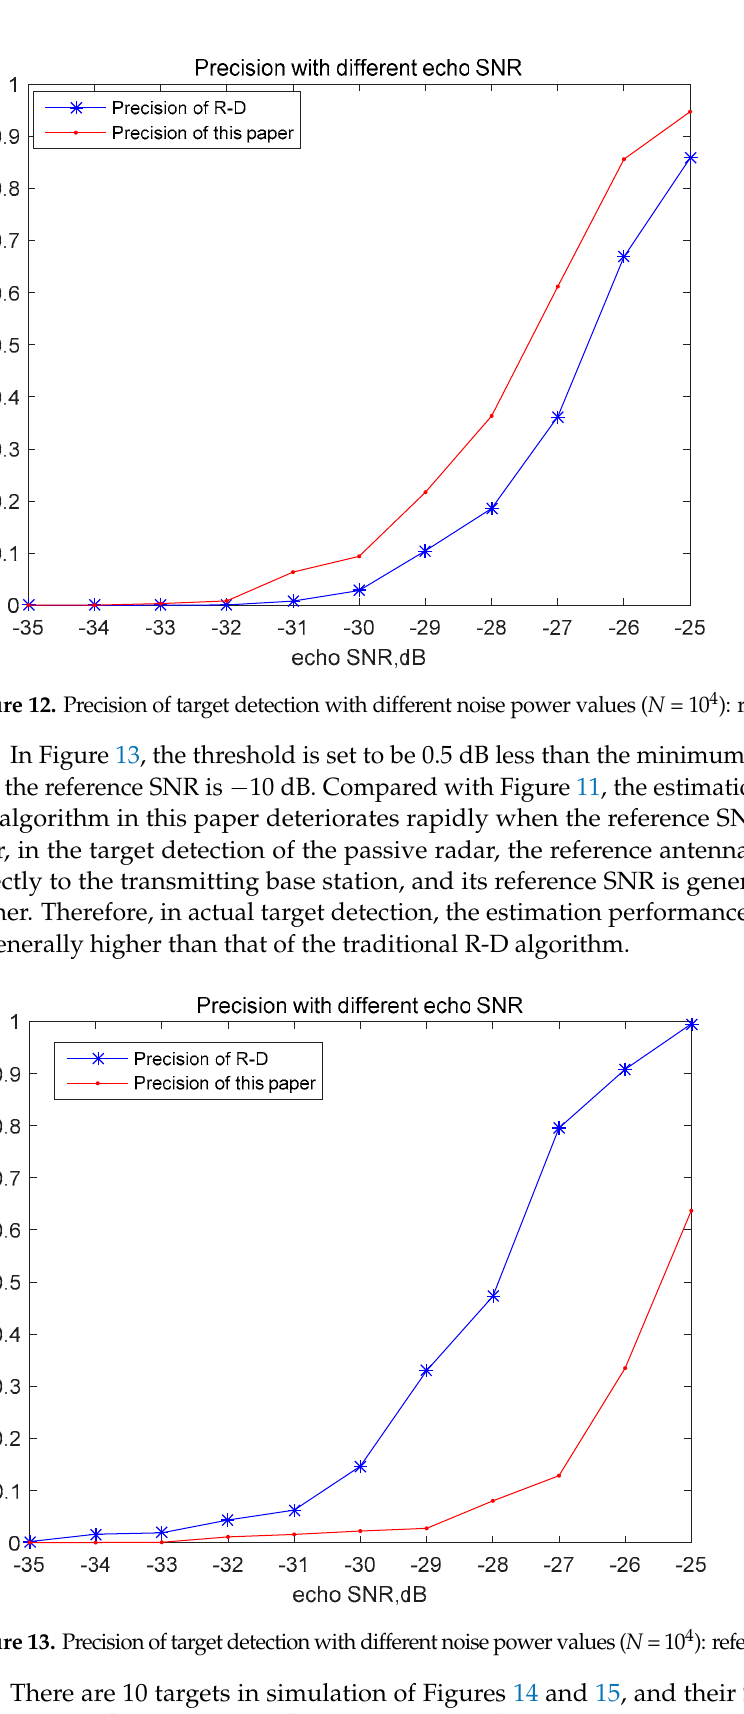
Figure 13. Precision of target detection with different noise power values ( N = 10 4 ): reference SNR = − 10 dB. There are 10 targets in simulation of Figures 14 and 15, and their SNR is uniformly distributed in [ − 40 dB, − 20 dB]. Each point in the figure has been subjected to 10,000 Monte Carlo simulations. The SNR reference channel is 10 dB in Figure 14 and it is − 5 dB in Figure 15. It can be seen from Figure 14 that the estimation performance of the algorithm in this paper is also higher than that of the traditional R-D algorithm. Compared with Figure 7, the results in Figure 14 are basically the same. That is, when the SNR of the reference channel is high, the estimation performance of the algorithm in this paper is basically not affected by the SNR of the reference channel. From the Figure 15, when the SNR of the reference channel is lower to − 5 dB, the algorithm in this paper is greatly affected, and its estimation performance is lower than that of the traditional R-D algorithm. When the SNR of the reference channel is relatively lower, it may be necessary to use reference channel purification methods (such as reference reconstruction) to improve the SNR of the refer- ence channel to ensure the algorithm performance.